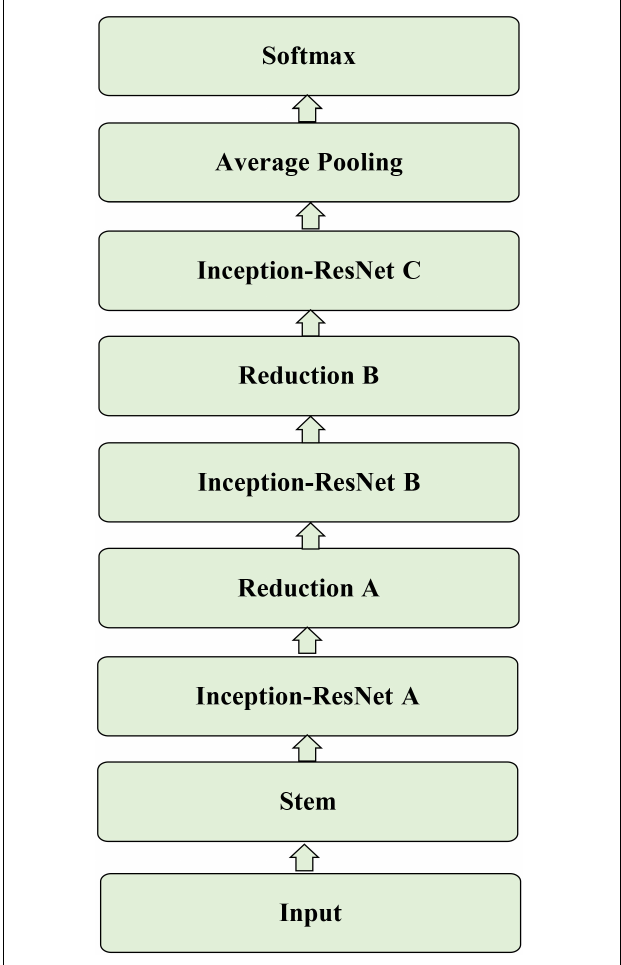
FIGURE 1 | The architecture of the Inception-ResNet-v2.